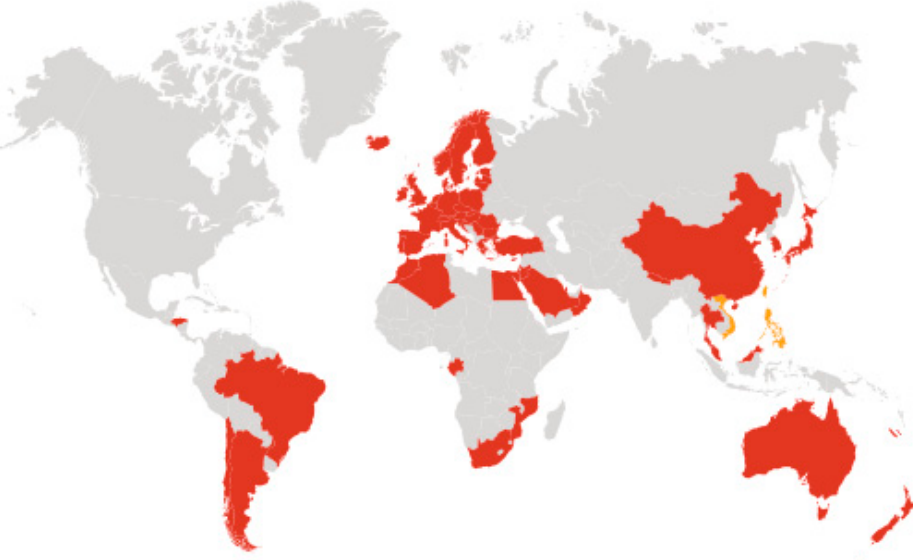
Figure 1. Countries with bans on asbestos. In red: countries with full or partial bans; in orange: countries expected to ban asbestos completely by 2020; in grey: countries with no bans [5].